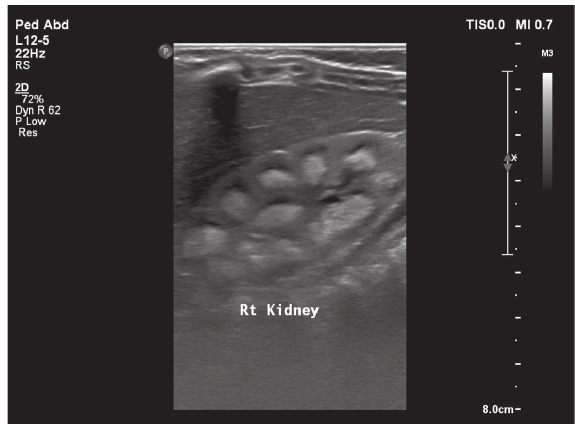
Figure 1: Ultrasound image of patient’s right kidney showing echogenic medullary pyramids suggestive of